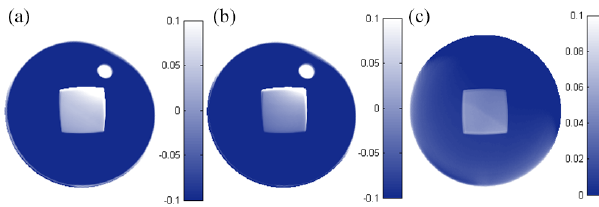
Figure 13. Relative difference in red radiance [–] between square − I square I overcast λ = λ = 620 620 ) for surface reflectance (a) and overcast clouds ( I overcast λ = 620 R = 0 . 08 and (b) R = 0; (c) difference between (a) and (b) , i.e., − I square − I square I overcast λ = I overcast λ = λ = 620 λ = 620 620 620 (( ) R = 0 . 08 − ( ) R = 0 ) . I overcast λ = I overcast λ = 620 620